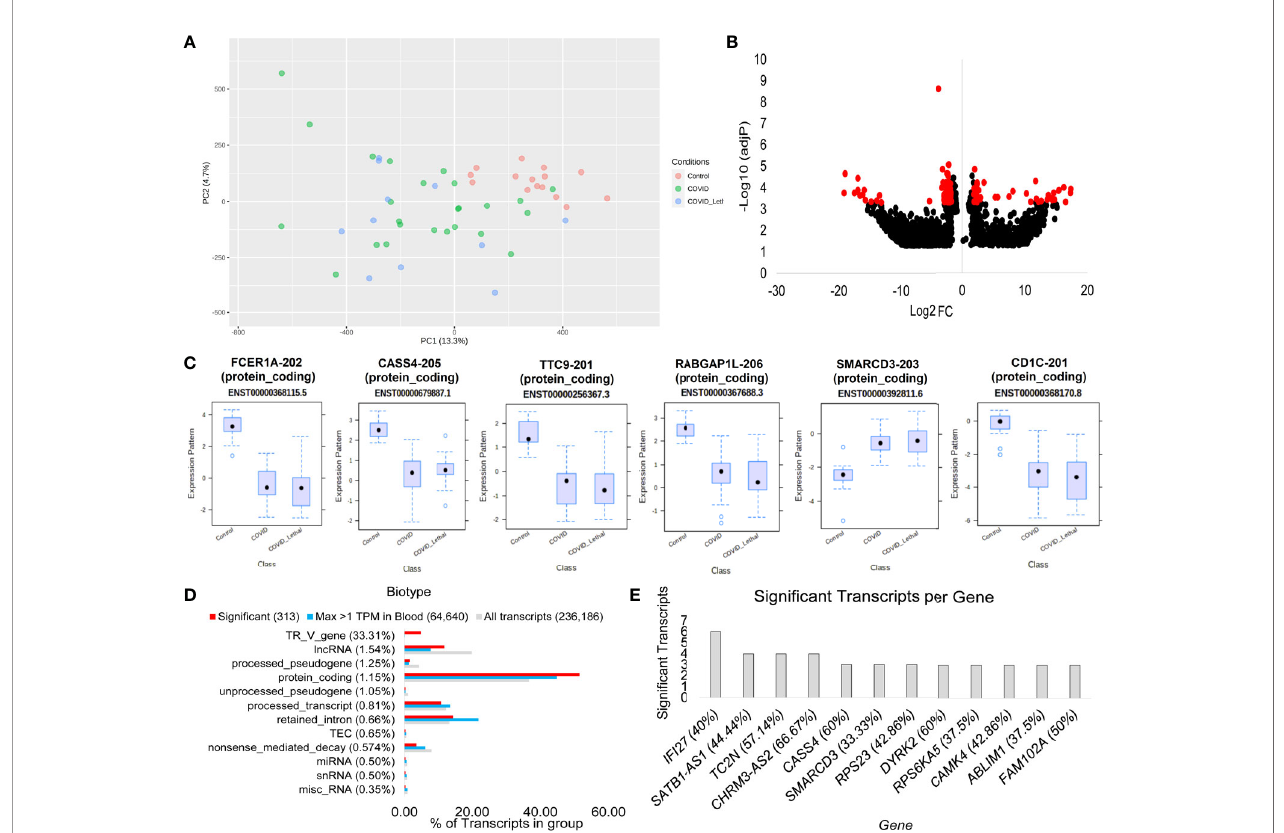
FIGURE 3 | Blood transcriptome transcript isoform signatures of SARS-CoV-2 patients. (A) Two dimensions of principal components (PC1-PC2) of fi rst collection time point RNAseq transcript annotations for samples of control (red), COVID-19 and survived (green), or COVID-19 and lethal (blue). (B) Volcano plot of transcript expression in COVID-19 or control patients with signi fi cant genes with a Log2 of 2 and adjP <0.0005 marked in red. The x-axis shows the log2 fold change, and the y-axis shows the -log10 of the adjusted p-value. (C) Box and whisker plot of the top six transcripts, with each having the transcript identi fi er, biotype, and Ensembl transcript ID listed. (D) Top biotypes enriched in the signi fi cant transcripts for COVID-19, with the percent listed in paratheses for each biotype annotation. The top biotypes are listed based on enrichment of signi fi cance annotation (red) relative to detection within blood within at least one sample with >1TPM (cyan). The percent of transcripts for the entire Gencode 38 database of 236,186 known transcripts is shown in gray. (E) The number of transcripts signi fi cantly different in the COVID-19 group relative to controls for each gene. The percent of transcripts identi fi ed signi fi cant relative to all known transcripts for each gene is shown in